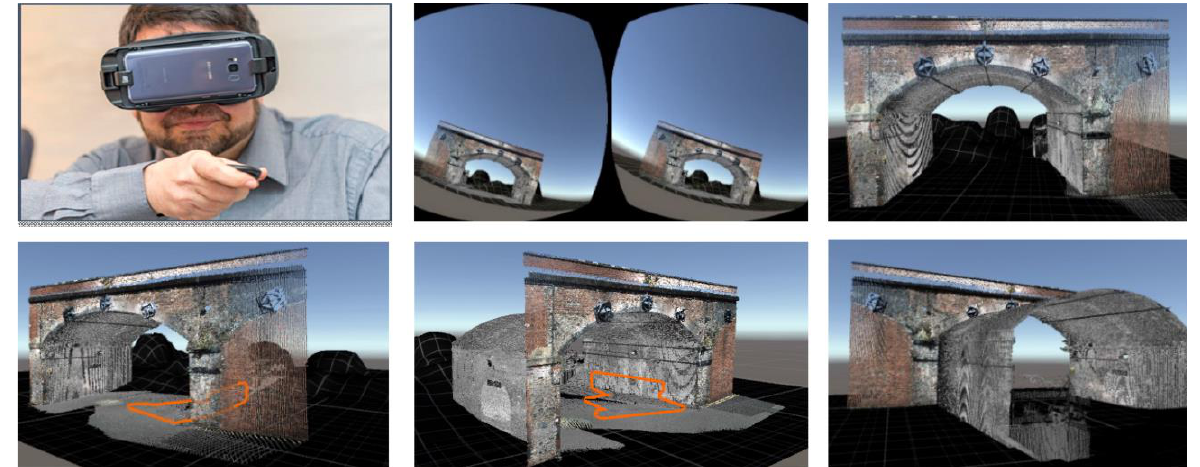
Figure 10. Multiple views of the bridge replicated in a 3D VR environment [94].